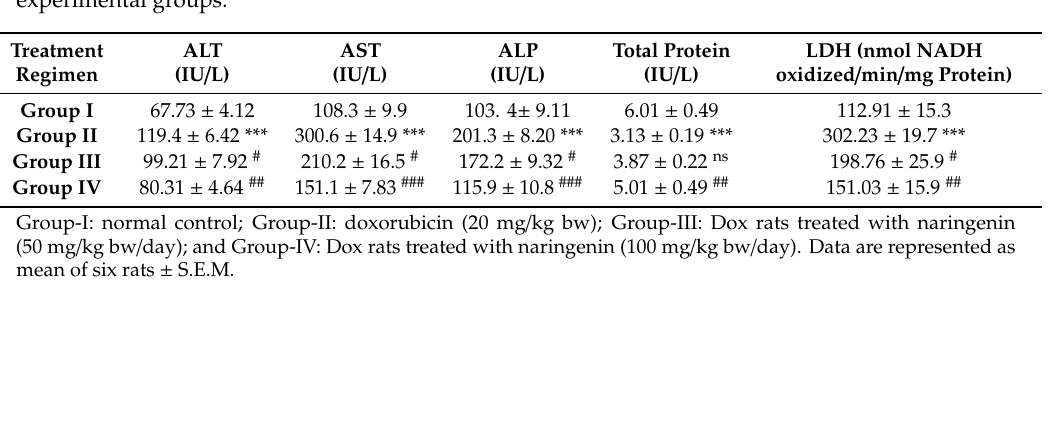
Table 3. E ff ect of treatment of naringenin on ALT, AST, ALP, LDH, and total protein in di ff erent Table 3. Effect of treatment of naringenin on ALT, AST, ALP, LDH, and total protein in different experimental groups. experimental groups.